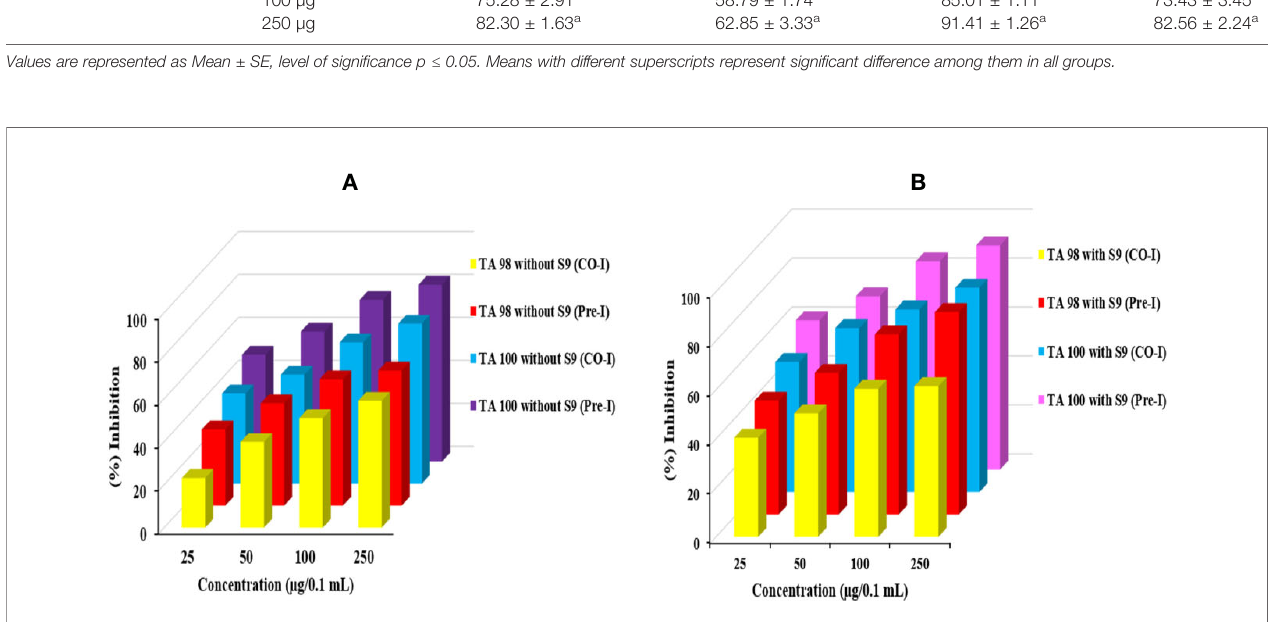
FIGURE 3 | Graph represents the antimutagenic potential of Obeth using S. typhimurium in Ames assay. (A) Represents the TA100 and TA98 without S9 (Pre and Co-incubation). (B) Represents TA100 and TA98 with S9 (Pre and Co-incubation). (A) Represent the percent inhibition between co- and pre-incubation in TA98 and TA100 strain without S9. (B) Represent the percent inhibition between co- and pre-incubation in TA98 and TA100 strain with